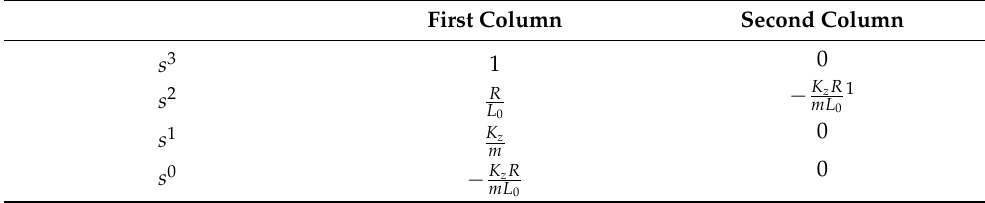
Table 2. Routh stability criterion table of suspension system.